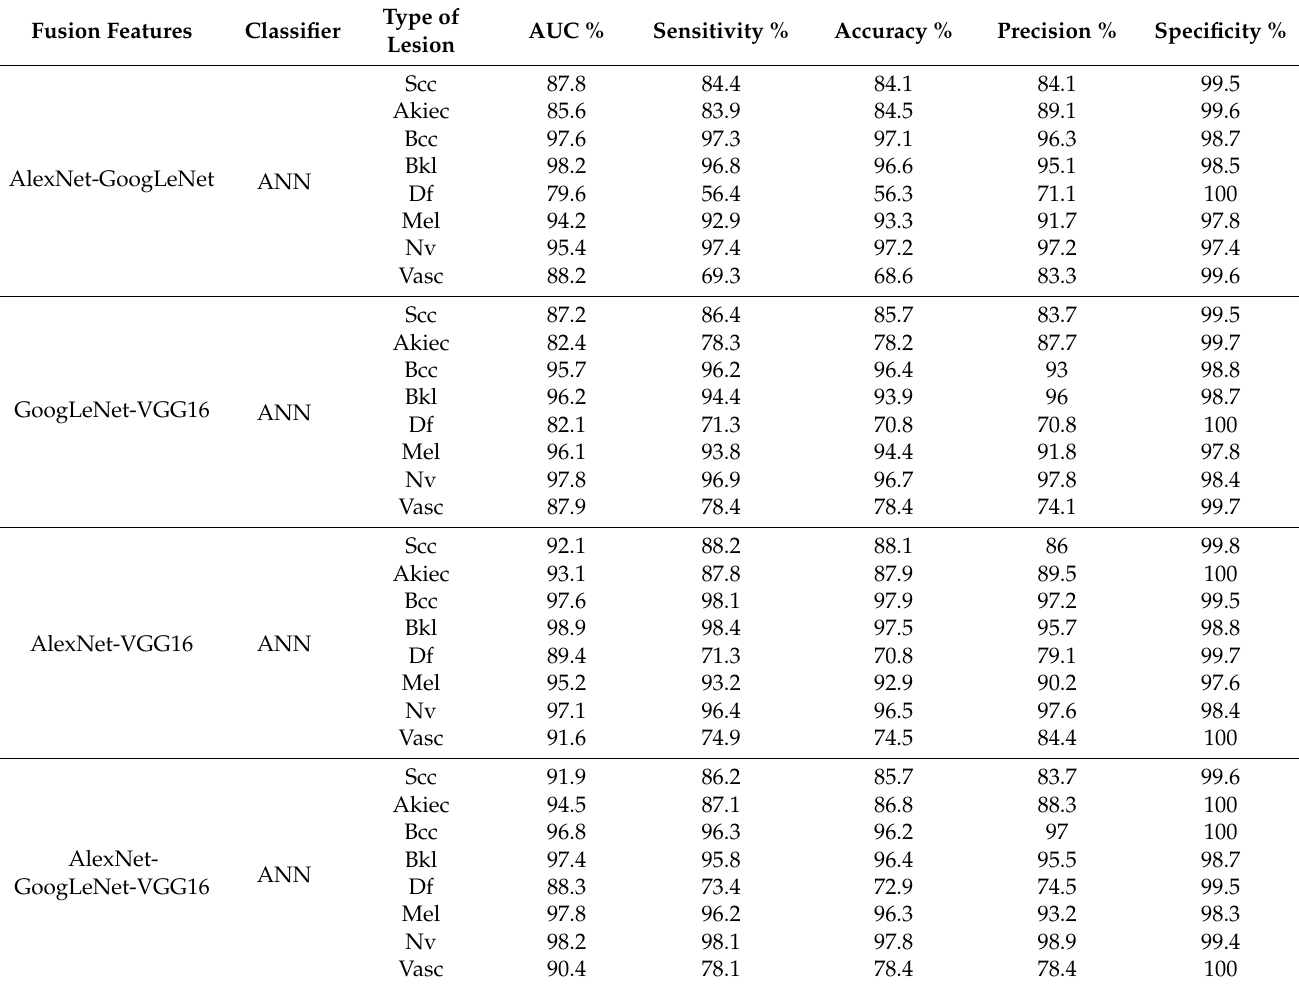
Table 7. Performance results of CNN-ANN hybrid models based on the fused CNN models for early diagnosis and differentiation of skin cancer and other skin